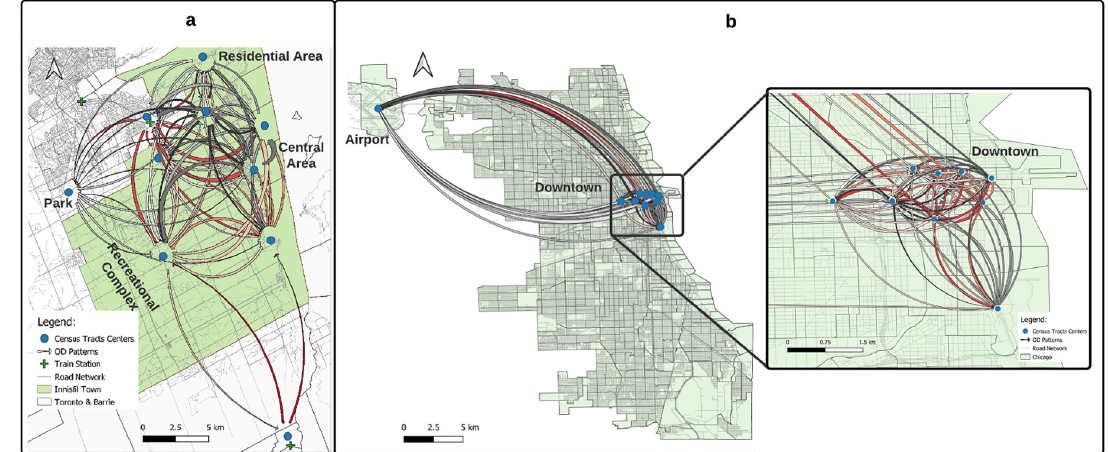
Fig 3. Origin-destination (OD) flow patterns for ridesourcing services during the pandemic in (a) Innisfil and (b) Chicago. In Innisfil, 52,126 ridesourcing trips were made from September 2020 till August 2021 covering 20 CTs, while more than 21 million trips were made in Chicago during the pandemic distributed over 803 CTs. Since it is hard to develop meaningful flow patterns for all OD pairs, we only display the flow patterns for the 10 most frequently used CTs in both locations. The OD flows shown in this figure represent 90% and 10% of the total trips in Innisfil and Chicago, respectively. The OD line color represents the origin of trips and the width reflects the flow strength. The wider the line is, the more trips the OD pair has. This figure was generated using the free and open- source software QGIS under the CC BY 4.0